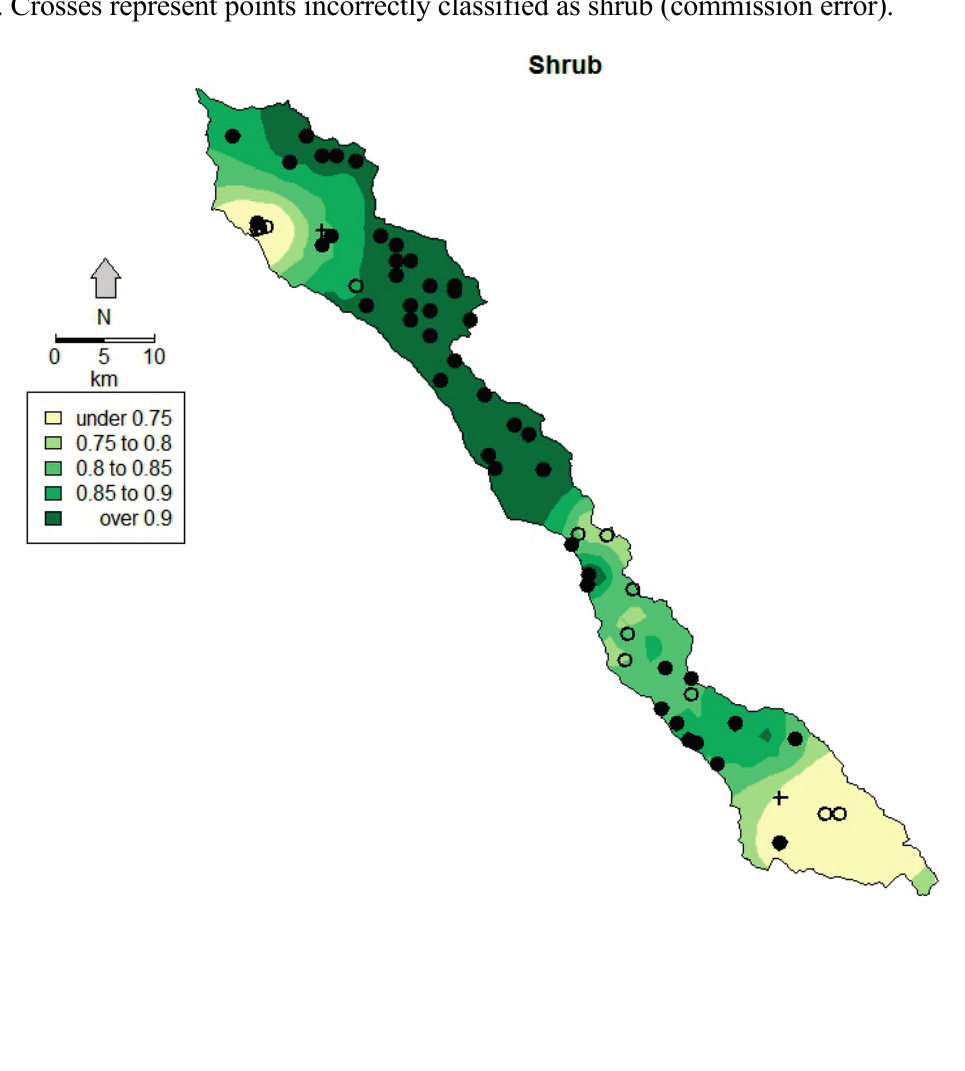
Figure 4. Maps of spatial distribution of accuracy for 2012 shrub cover. Values in the legend represent the probability of the presence of the correct class. Maps of agreement between the reference data and the classified map for 2012. Solid circles represent agreement in both data sets. Unfilled circles represent shrub points incorrectly classified as forest or grass (omission error). Crosses represent points incorrectly classified as shrub (commission